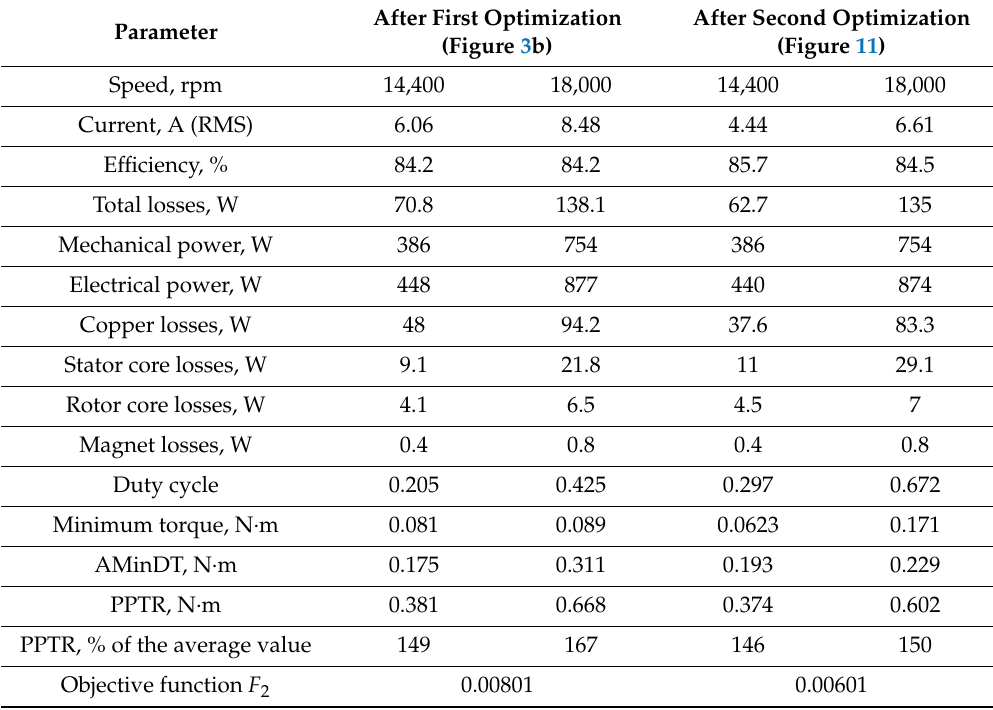
Table 6. The FRM characteristics before and after the second